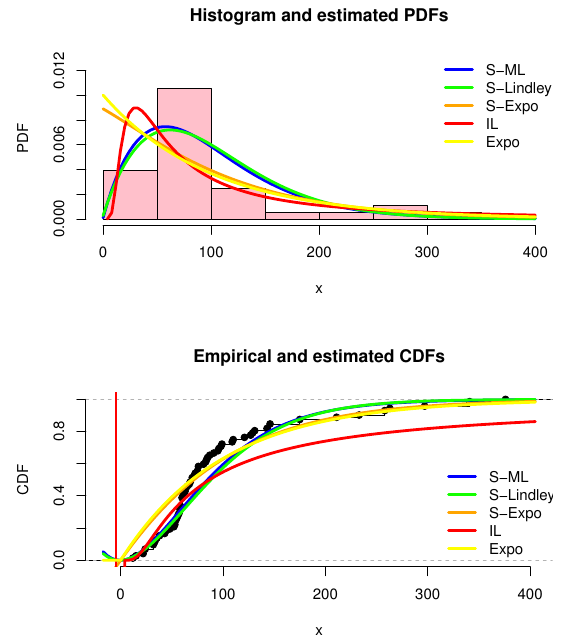
Figure 5. EPDF and ECDF plots for the survival times of Guinea